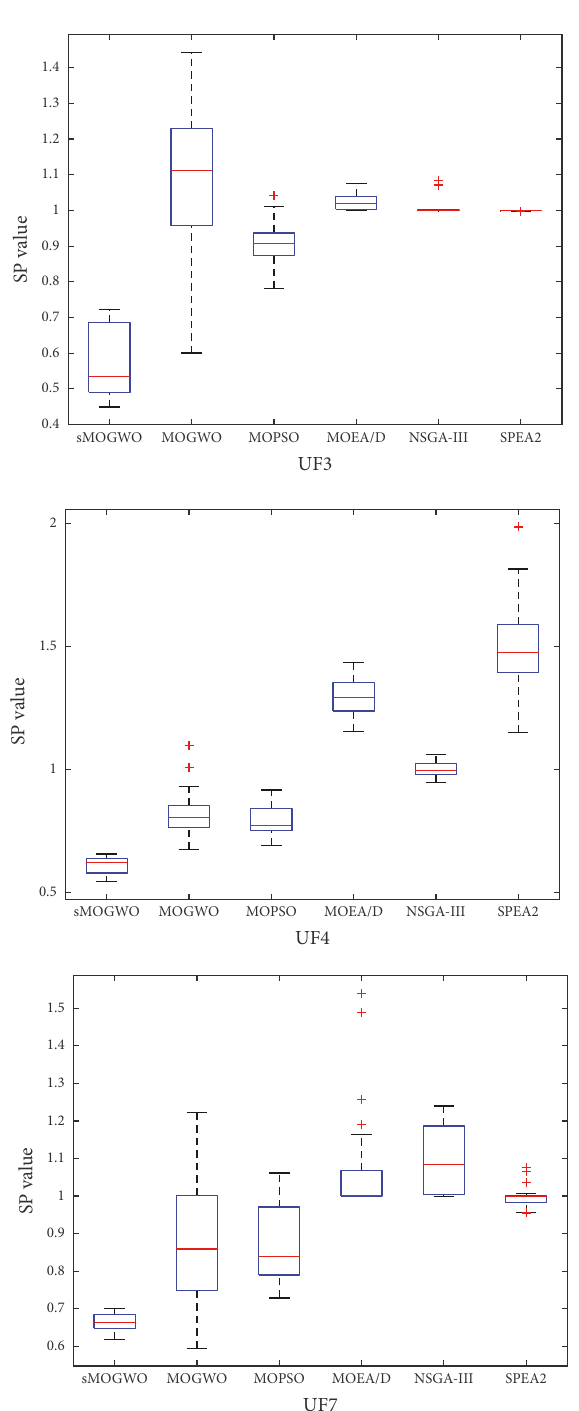
Figure 6: The boxplots of SP value of three algorithms.